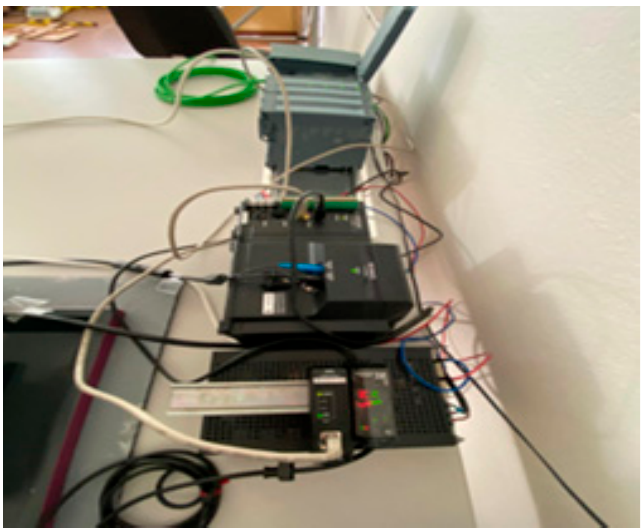
Figure 3. Measuring scheme of LTS, containing amplifier IL-1000, profinet module DL-PN1, PLC module Siemens 1511C.